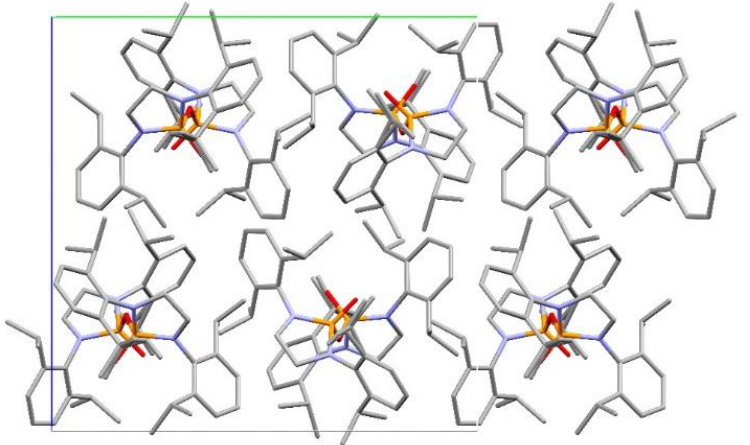
Figure 13. Structure of O((C 2 H 4 (2,5- i PrPhN) 2 ) 2 PO) 2 as viewed along the a-axis (generated in Mer- cury [25]).